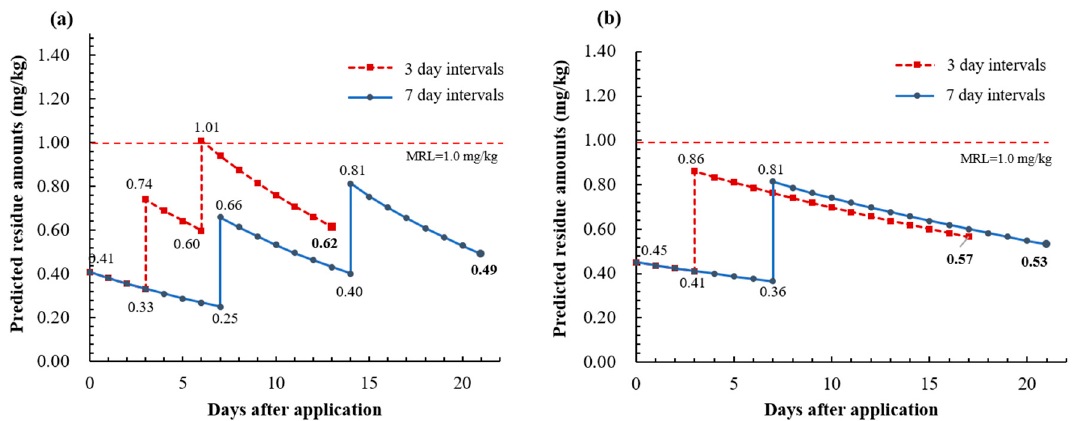
Figure 5. Predicted residue levels for multiple applications (three- and seven-day intervals) of acetamiprid ( a ) and chlorantraniliprole ( b ).